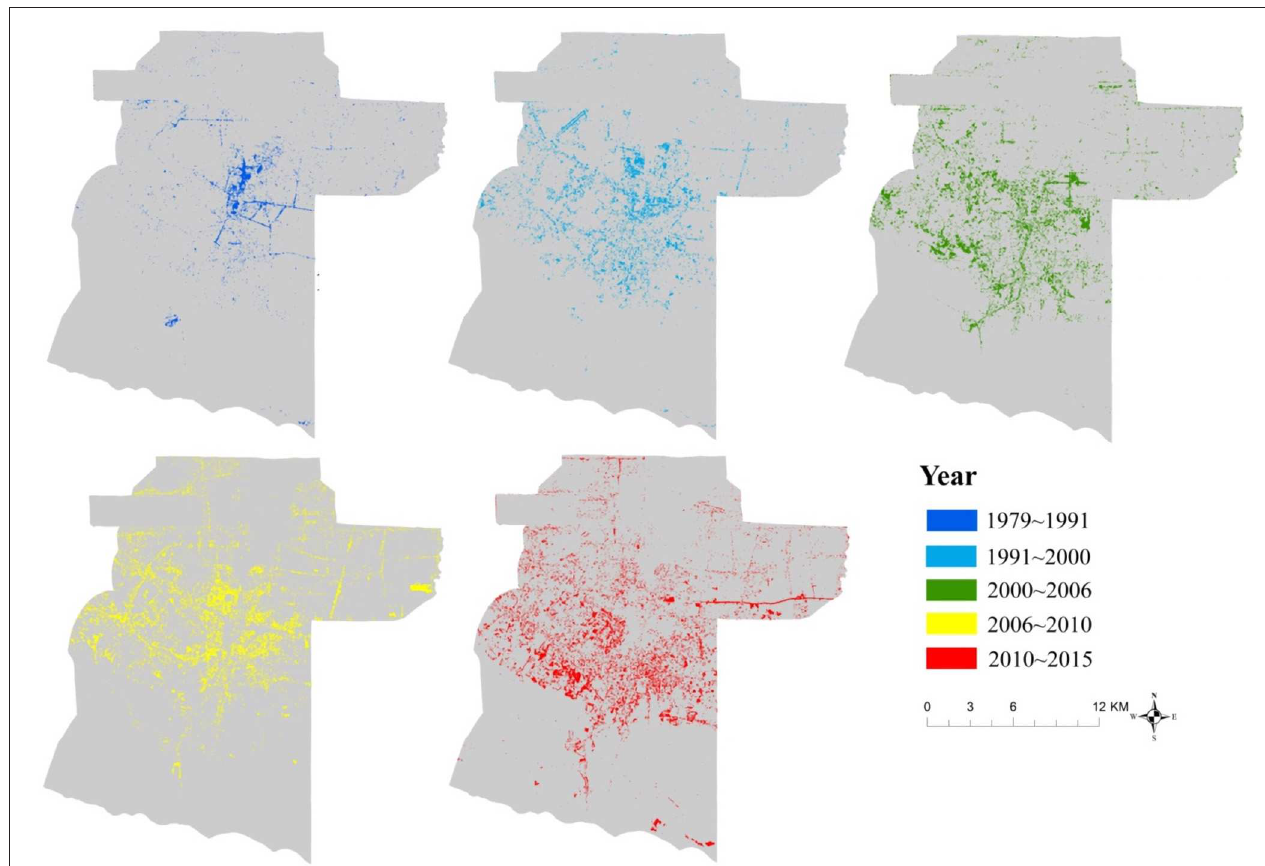
FIGURE 7 | Spatial changes in Urban and Built-up land from 1979 to 2015.